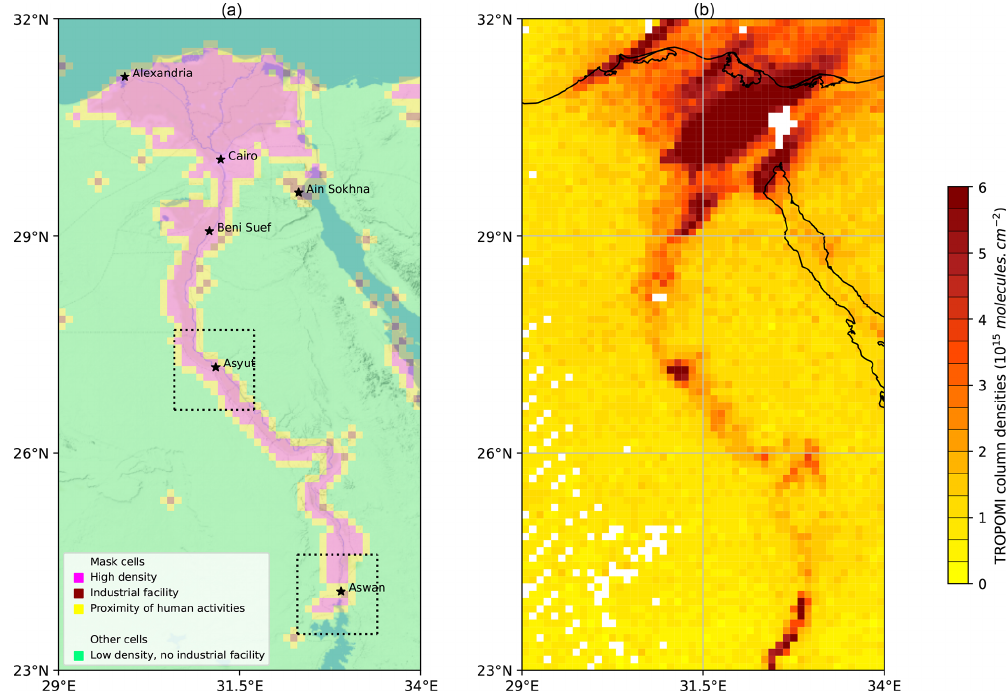
Figure 1. (a) Part of Egypt centred on Nile River. Within this domain, pink cells represent locations with an average human density above 100 inhabitants per square kilometre, brown cells represent locations with industrial facilities outside cities and yellow cells represent loca- tions in their vicinity. These cells constitute the mask used to calculate anthropogenic emissions. Outside this mask, green cells represent areas which do not correspond to any of the three criteria, considered to be void of human activity. Five large cities in the country and the industrial area of Ain Sokhna are denoted with stars. Two smaller domains centred around the cities of Asyut and Aswan are repre- sented with dotted lines; their use is presented in Sect. 4.6. (b) TROPOMI observation of NO 2 slant column densities above Nile valley on 3 January 2019. White pixels correspond to areas with low-quality data ( q a < 0 . 75) or no